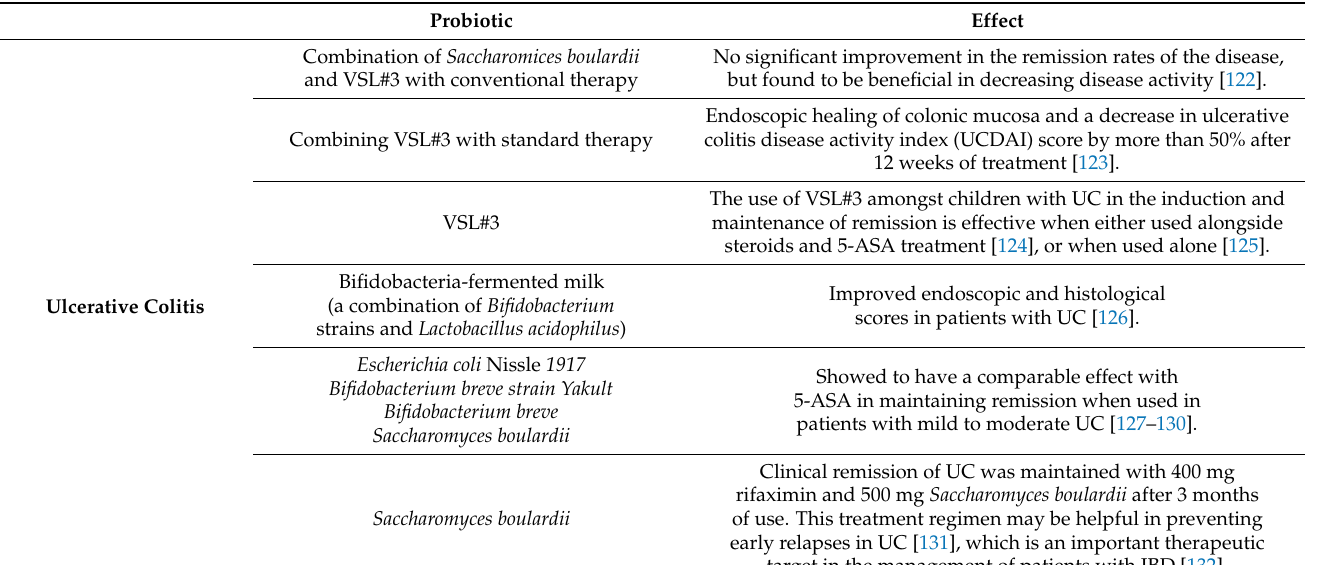
Table 6. Cont. Probiotic Effect